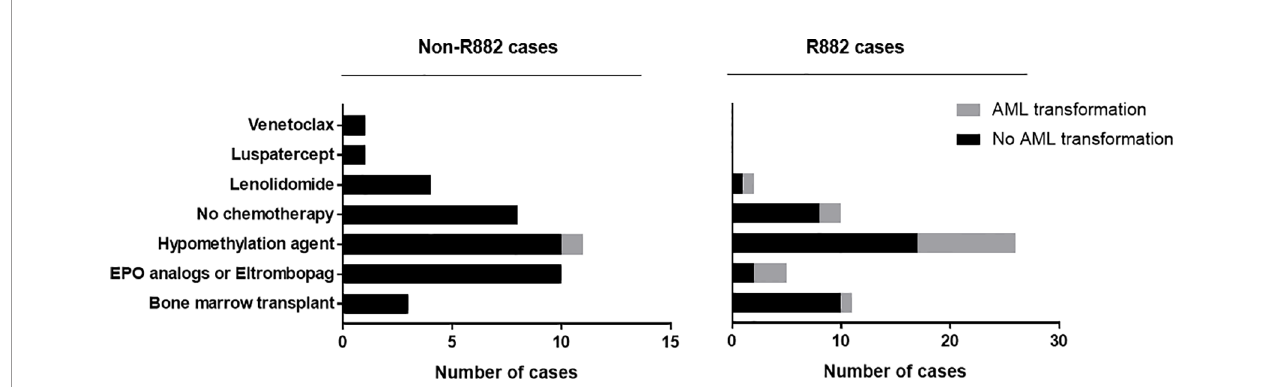
FIGURE 5 | MDS treatment approaches and AML transformation. Treatmentinformation was collectedfor 53 out of 62 MDS patients with DNMT3A R882 mutations, and 38 out of62 patients with DNMT3A non-R882 mutations. Different treatment approaches were listed together with the occurrence